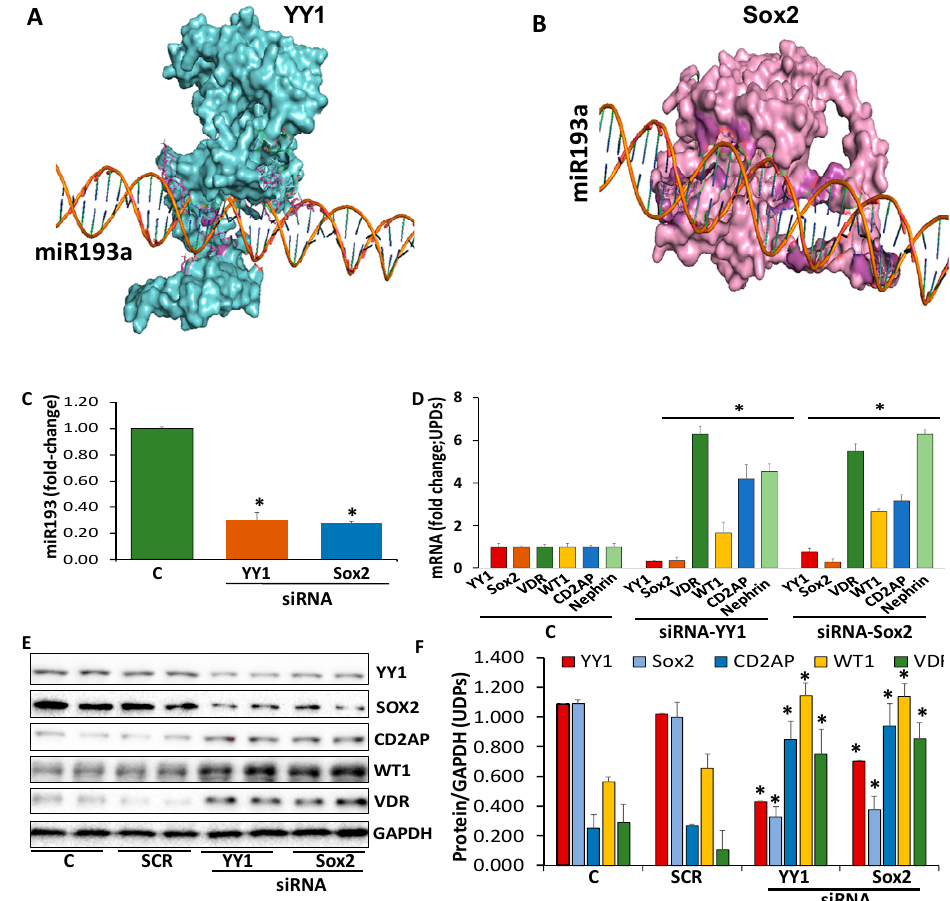
Figure 3. Evaluation of the transcription factors enhancing miR193a expression and associated downstream signaling. ( A ) YY1-miR193a complex. YY1 (Cyan) binds on miR193a promoter; the interacting residues (Magenta) are displayed. ( B ) Sox2-miR193a complex. Sox2 (Pink) binds on miR193a promoter and interacting residues (Magenta) are shown. ( C ) UPDs were transfected with siRNA-YY1 or SiRNA-Sox2 (n = 3). After 48 h, RNAs were extracted from control (C) and siRNA-YY-1 and siRNA-Sox2-transfected UPDs. RNAs were assayed for miR193a. Cumulative data are shown in a bar diagram. * p < 0.05 compared with control (C). ( D ) cDNAs were prepared from the RNAs extracted from the protocol A. cDNAs were amplified with specific primers for YY1, Sox2, VDR, WT1, CD2AP, and Nephrin (n = 3). Cumulative data are shown in a bar diagram. * p < 0.05 compared with respective controls (C). ( E ) UPDs were transfected with either scrambled (SCR), siRNA-YY1, or siRNA-Sox2 (n = 3). After 48 h, proteins were extracted from control, SCR-, siRNA-YY1- and siRNA-Sox2-transfected podocytes. Protein blots were probed for YY1, Sox2, CD2AP, WT1, VDR, and GAPDH. Representative gels from two di ff erent lysates are displayed. ( F ) Cumulative densitometric data from protein blots of protocol C are displayed in a bar diagram. * p < 0.05 compared with respective control and